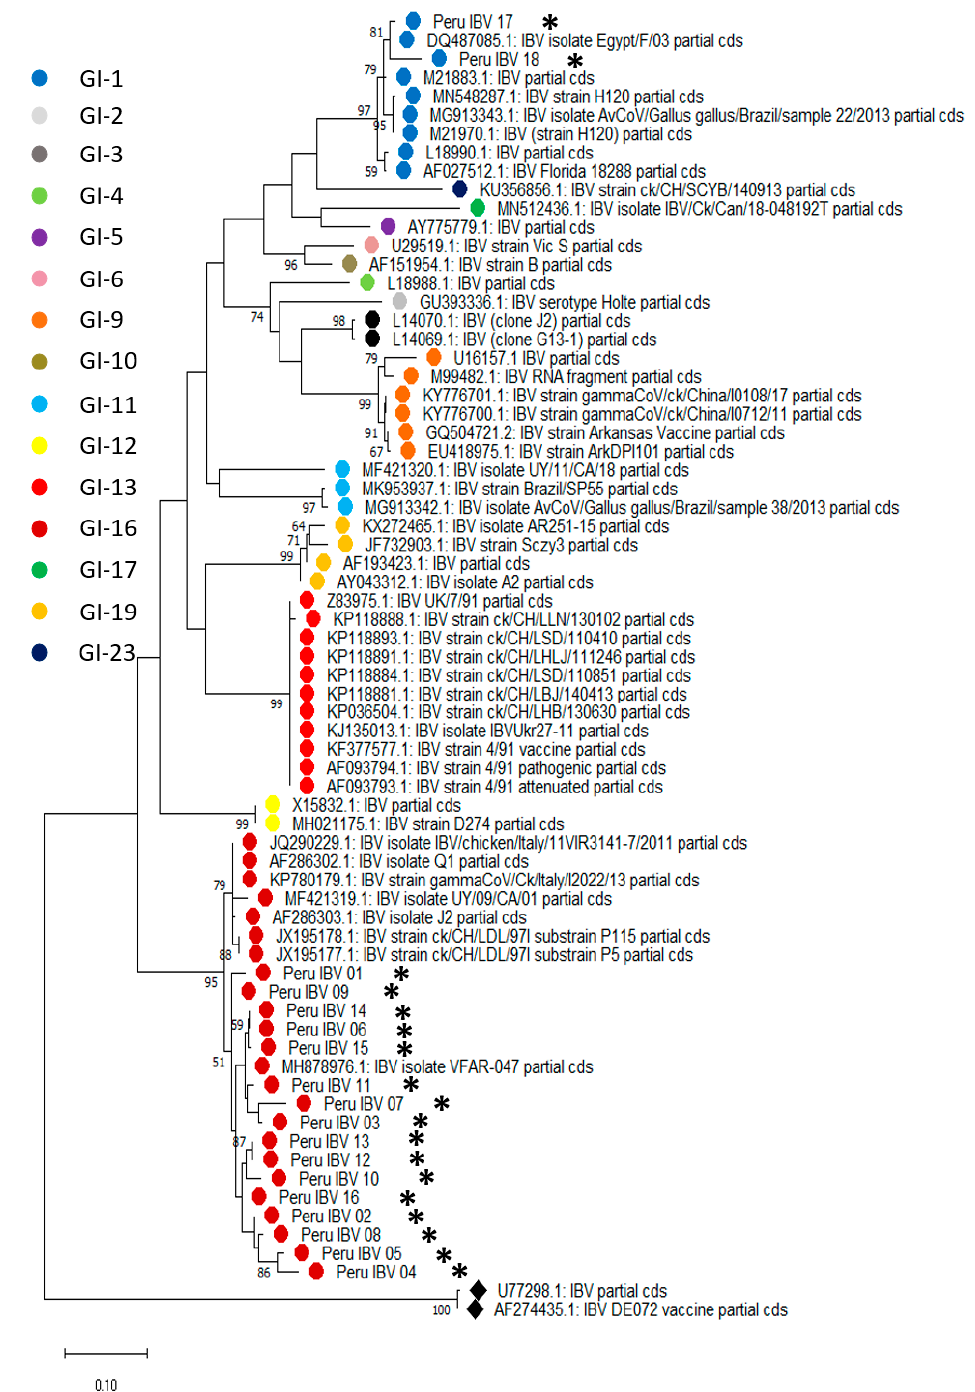
Figure 2. Phylogenetic analysis reveals GI-16 and GI-1 circulation in poultry farms in Peru. Isolated samples were processed for RNA extraction and a PCR that targeted the hypervariable region III (HVR-III) allowed the identification of GI-16 and GI-1 lineages in Peru. The evolutionary history was inferred by using the maximum likelihood method and tamura 3-parameter models. The percentage of trees in which the associated taxa clustered is shown next to the branches. A discrete gamma distribution was used to model evolutionary rate differences among sites. The tree is drawn to scale, with branch lengths measured in the number of substitutions per site. This analysis involved 70 nucleotide sequences. Evolutionary analyses were conducted in MegaX. Asterisks represent the sequences obtained in the current study.